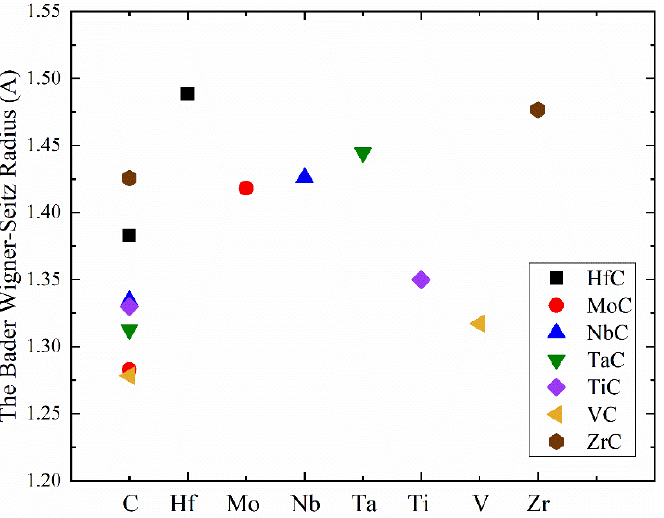
Figure 2. The Bader WS radius (Å) for MC (M = Hf, Mo, Nb, Ta, Ti, V, Zr). Table 1. Listed are the formation enthalpy ∆ H (in KJ/mol), average radial displacement ∆ d (in Å) for individual alloy components, total radial displacement tot. , and atomic misfitting difference δ in the considered HECs. The available experiments are from Reference [12]. ∆ H 1 = E HEC − ∑ i c i E MC , with E MC for the energy of binary carbides, ∆ H 2 = E HEC − ∑ i c i E i , with c i for the composition and E i for the energy of ground state of elements (graphite for HCP, Hf, Ti, Zr, BCC for Mo, Nb, Ta, V).